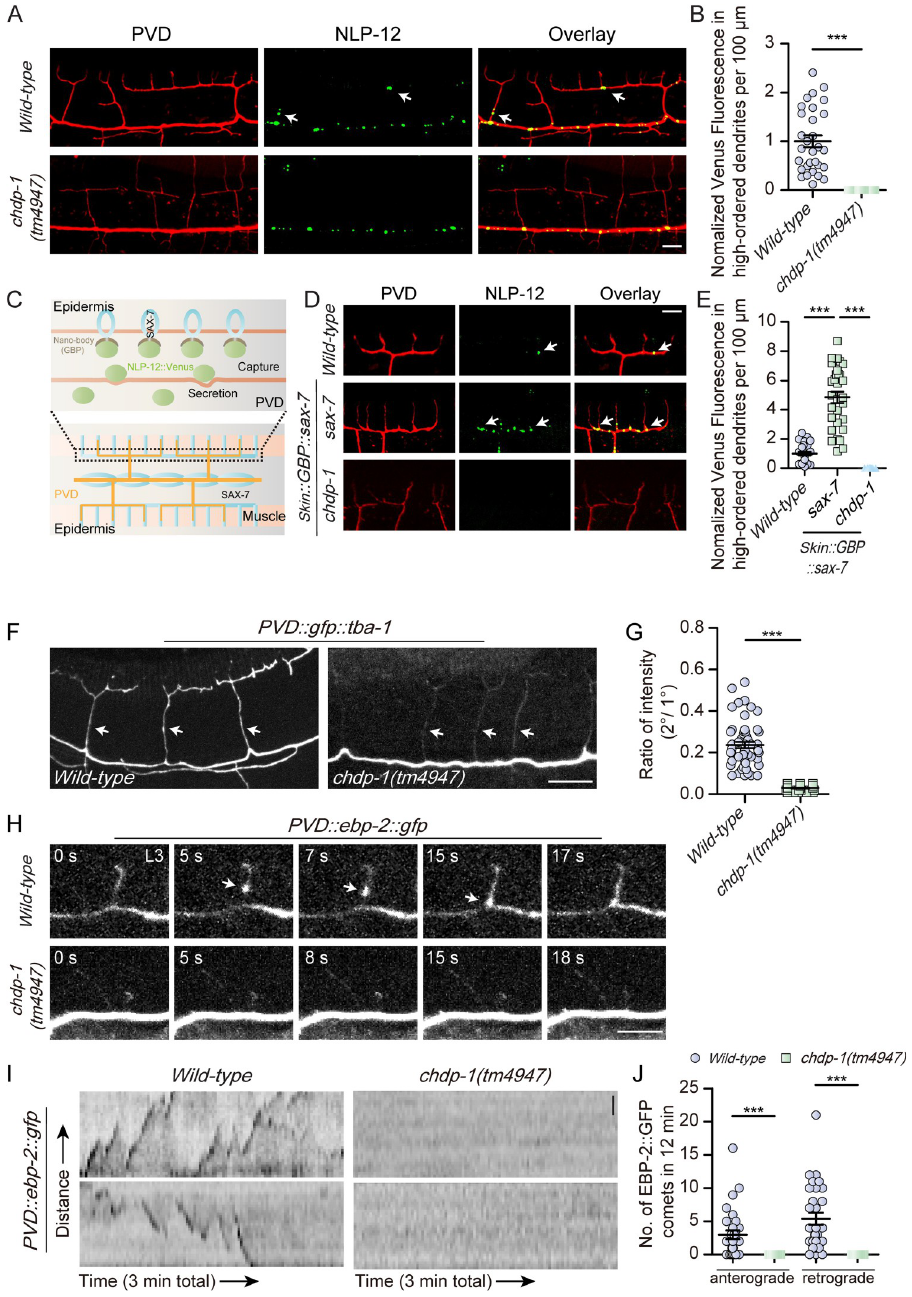
Fig 6. Loss of chdp-1 affects assembly of microtubule cytoskeleton and organelle transport in the high-ordered dendrites. (A) Confocal images of PVD dendrites (left), NLP-12 (NLP-12::Venus) (middle), overlay (right) in wild- type (upper), chdp-1(tm4947) mutant (lower). Arrows: NLP-12::Venus-positive dense-core vesicles in the high-ordered branches. Scale bar: 20 μ m. (B) Quantification of NLP-12::Venus fluorescence intensity in the higher-ordered dendrites in a 100 μ m area anterior to the PVD cell body (normalized to WT). Error bars: SEM. ��� p < 0.001 by Student’s t test. n = 20–30 for each genotype. (C) A cartoon showing the spatial localization of SAX-7 in the epidermis and the rationale of using SAX-7 fused with anti-GFP nanobody (GFP-binding protein, GBP) to capture NLP-12:: Venus secreted from PVD dendrites. (D) Confocal images of PVD dendrites (left), NLP-12 (middle), overlay (right) in wild-type (upper), sax-7(nj48) (middle), chdp-1(tm4947) (lower). Note that both sax-7(nj48) and chdp-1(tm4947) strains carrying a transgene to express GBP::SAX-7 in the epidermis. Arrows: NLP-12::Venus vesicles in the high- ordered branches. Scale bar: 5 μ m. (E) Quantification of NLP-12::Venus fluorescence intensity around the high- ordered dendrites in a 100 μ m area anterior to the PVD cell body (normalized to WT). Error bars, SEM. ��� p <